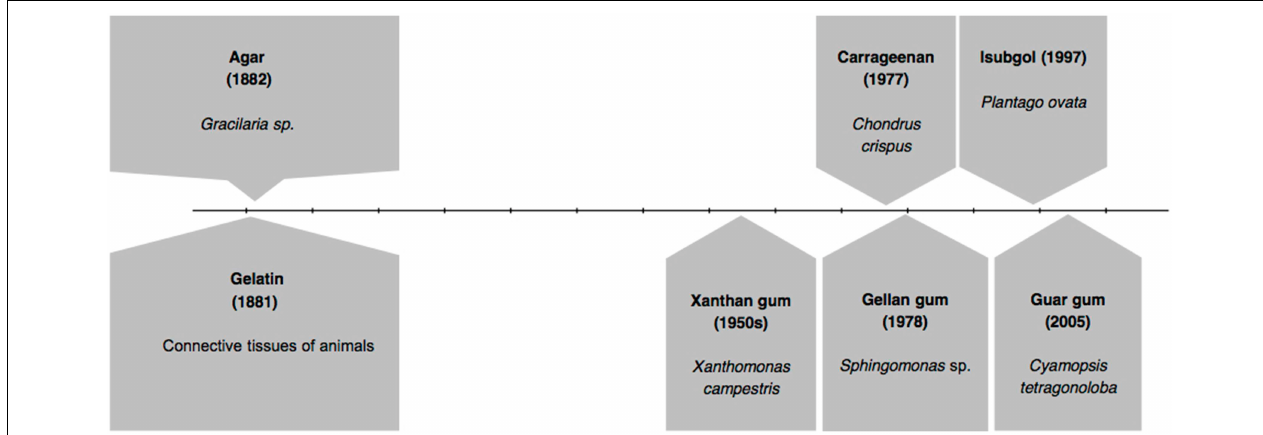
FIGURE 1 | Timeline of discovery of various gelling